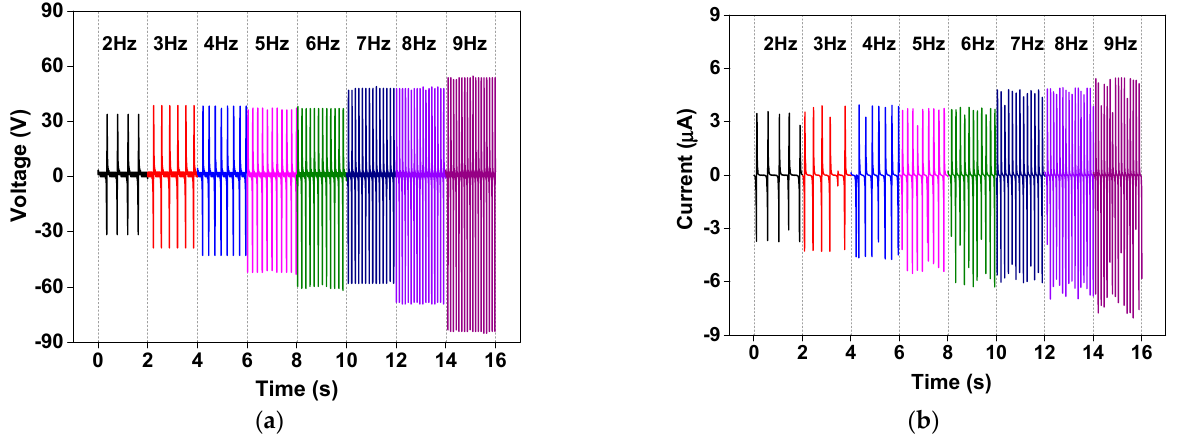
Figure 8. ( a ) Voltage and ( b ) current outputs of the NR@AgNPs (1.5 mM CTAB) TENG at various operation frequencies ranging from 2 to 9 Hz.